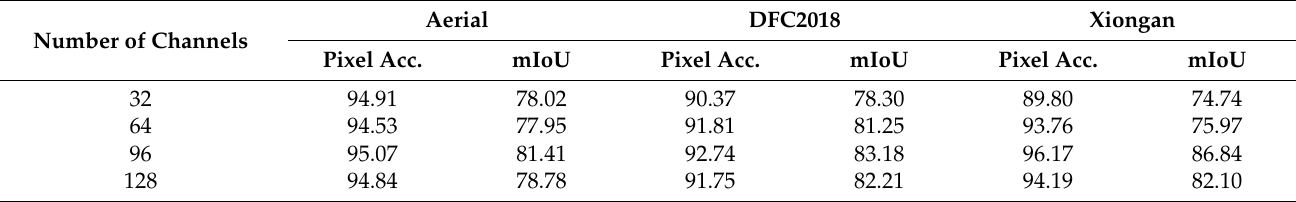
Table 10. Influence of number of channels on the performance of